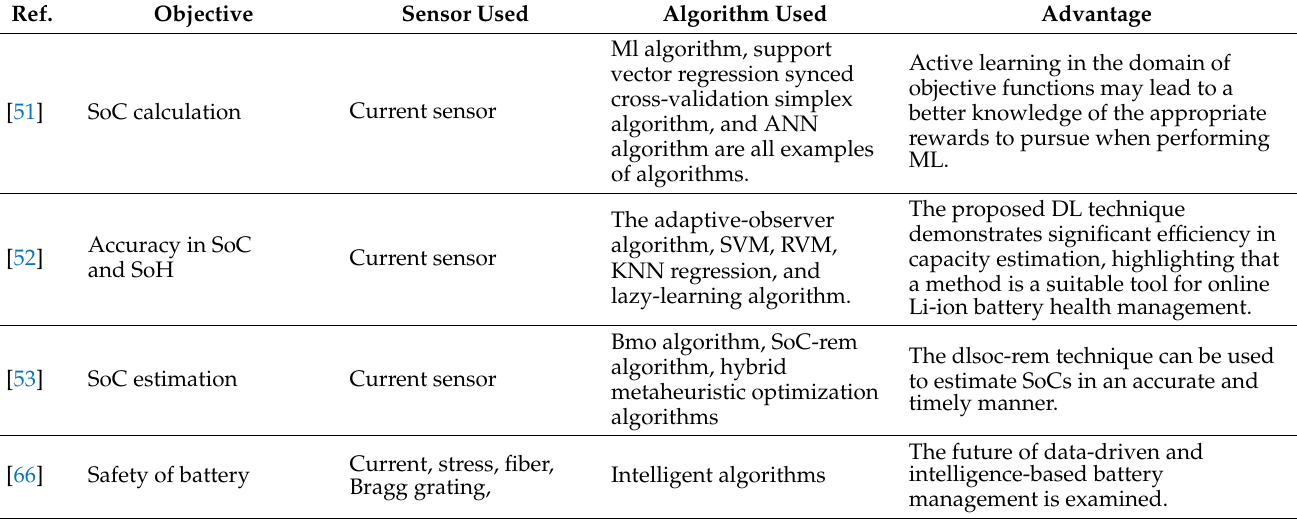
Table 6. A detailed survey on AI-ML-NN and deep learning in battery-management